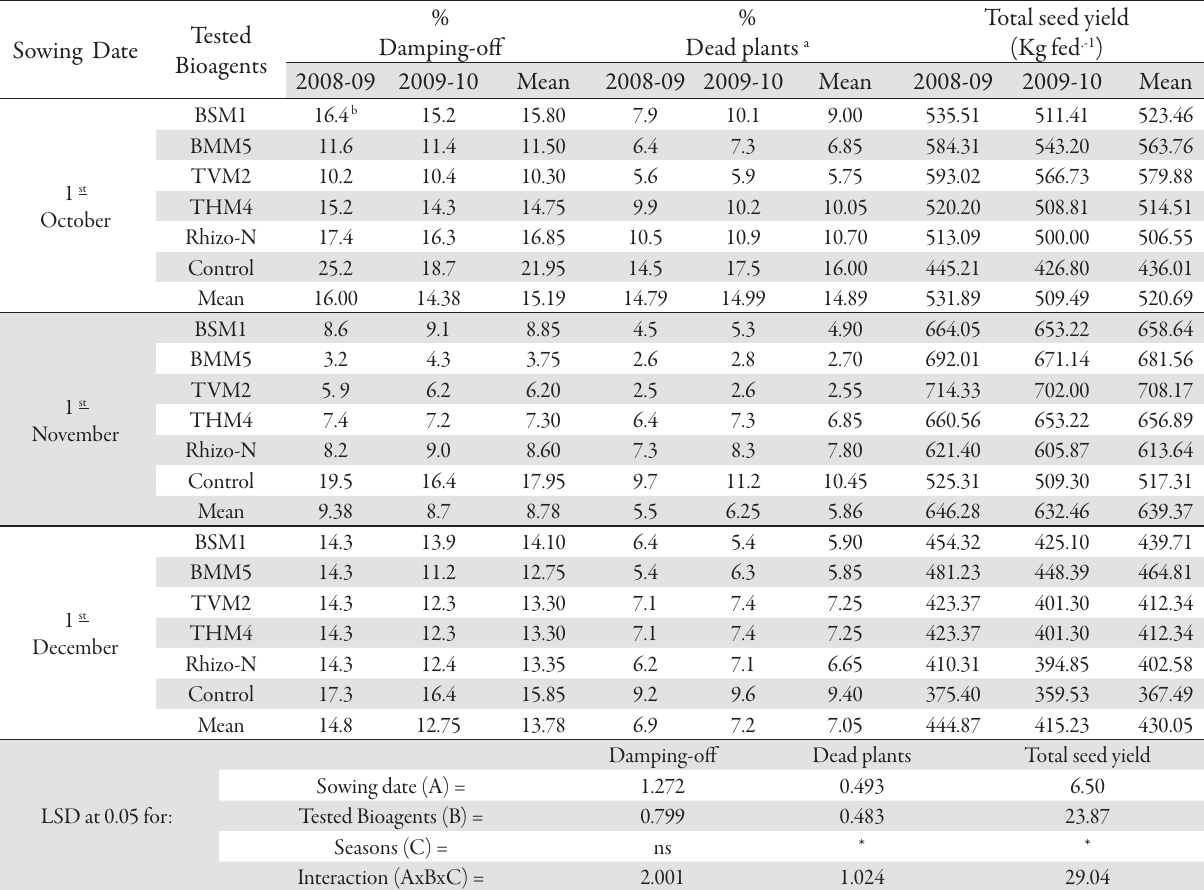
Tab. 6. Effect of treatment chickpea seeds (cv. ‘Giza 3’) with bioagents on damping-off, root and stem rot and seed yield during 2008-2009 and 2009-2010 growing seasons under field conditions at New Valley governorate Sowing